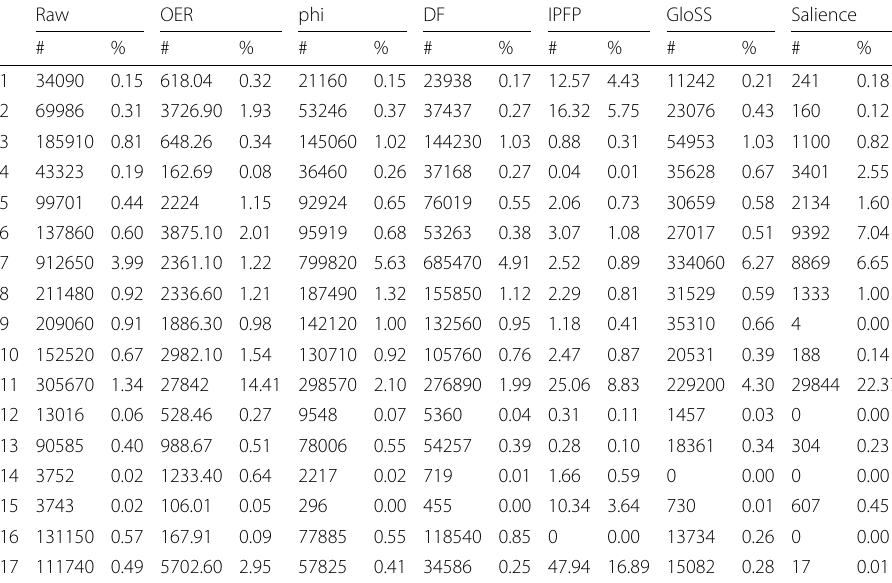
Table 20 The sum of link weight and the percentage of total link weight of the constructed networks that fall within each of the 17 disease categories in the coarse-grained network Raw OER phi